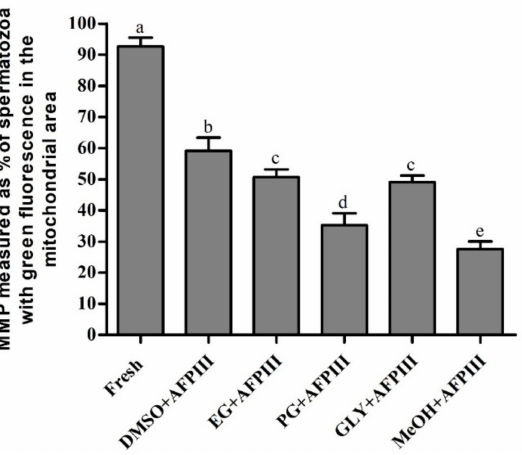
Figure 5. Mitochondrial membrane potential (MMP) (%) of Pacific abalone sperm cryopreserved with antifreeze protein III (AFPIII). Significantly different levels ( p < 0.05) are denoted by different